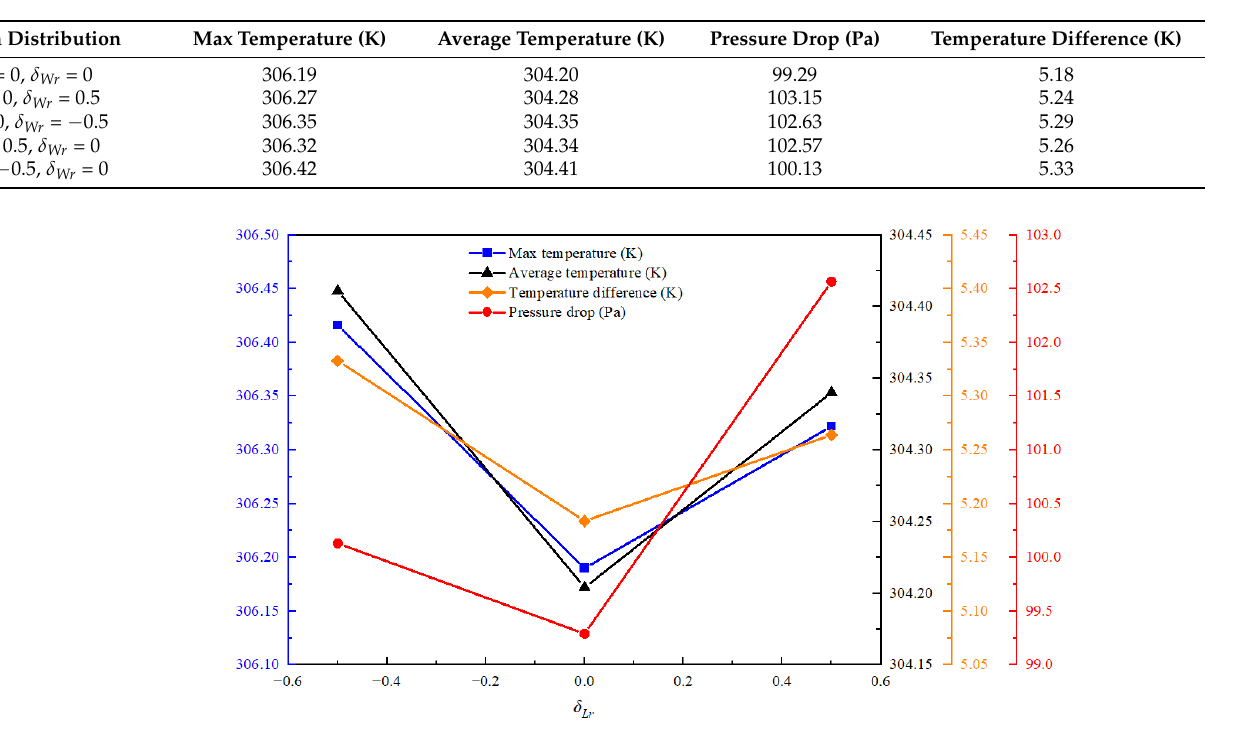
Table 7. Effect of various pin-fin distributions.